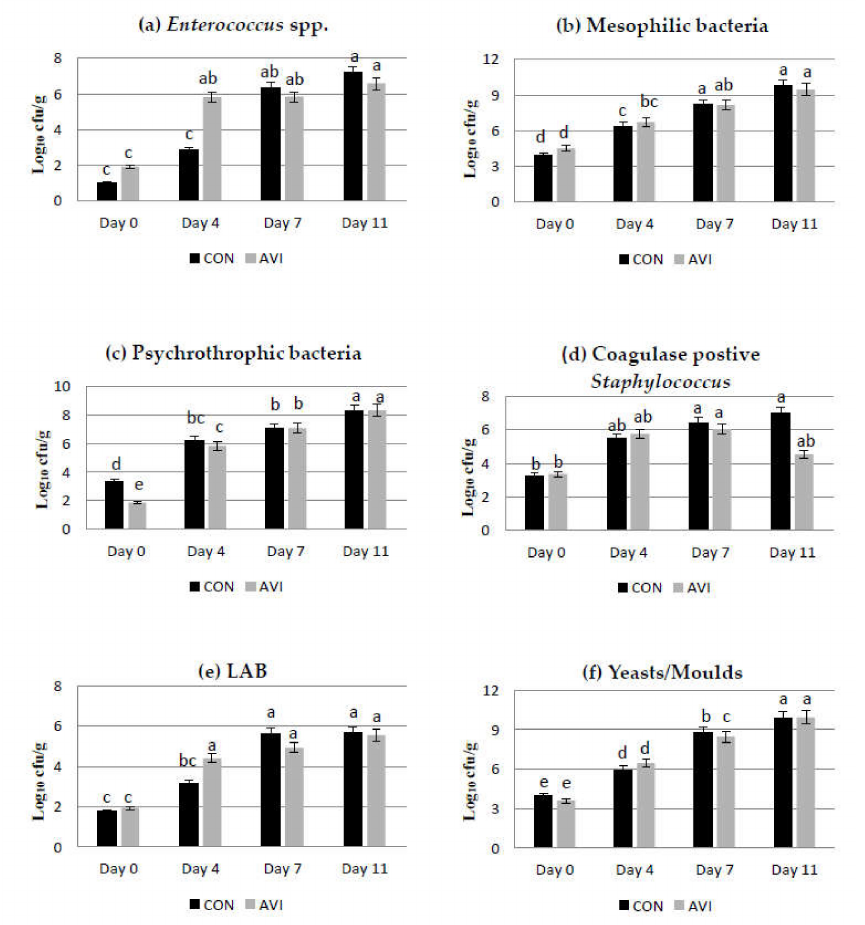
Figure 1. Interactive e ff ect of dietary treatments (CON, basal diet; AVI, basal diet + 0.5% organic acids and essential oils) and storage time (days 0, 4, 7 and 11) on microbial counts of raw meat, expressed as log 10 cfu / g: ( a ) Enterococcus spp.; ( b ) mesophilic bacteria; ( c ) psychrotrophic bacteria; ( d ) coagulase-positive Staphylococcus ; ( e ) Lactic Acid Bacteria (LAB); ( f ) yeasts / moulds. a–e Values with di ff erent superscripts are significantly di ff erent ( p <